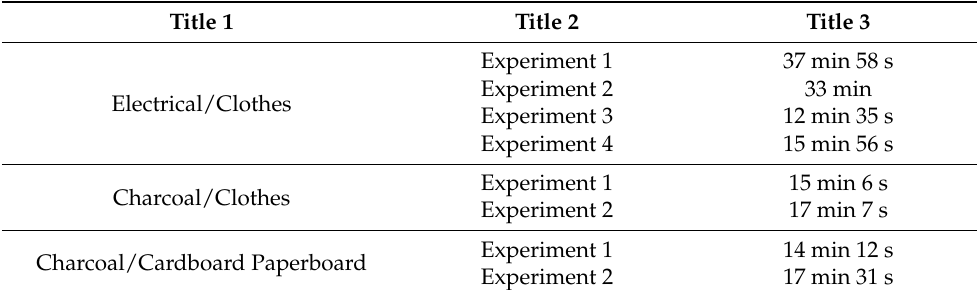
Table 1. Time duration for each conducted